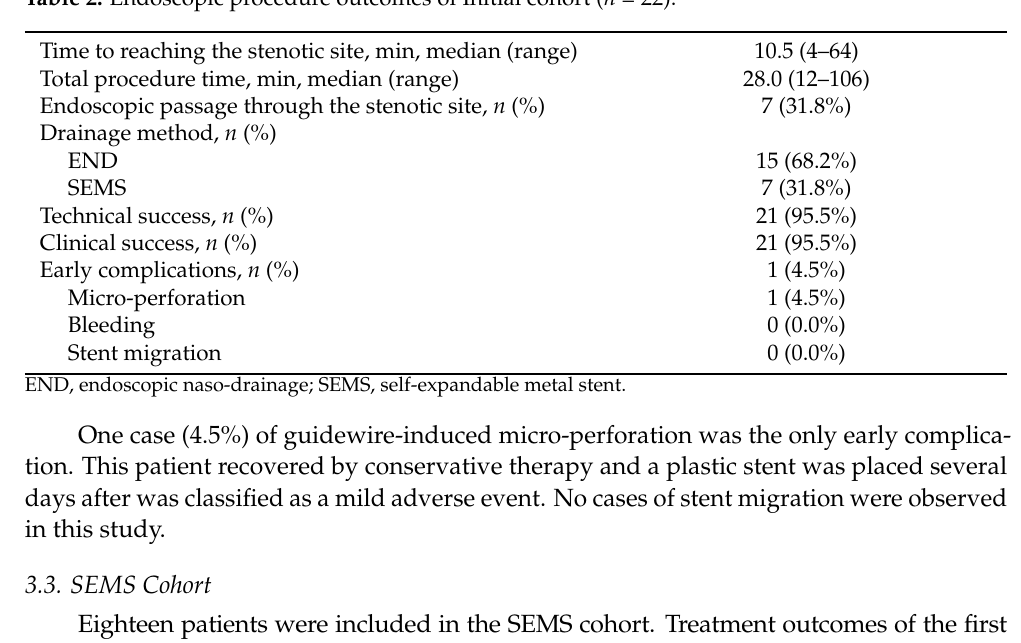
Table 2. Endoscopic procedure outcomes of Initial cohort ( n =